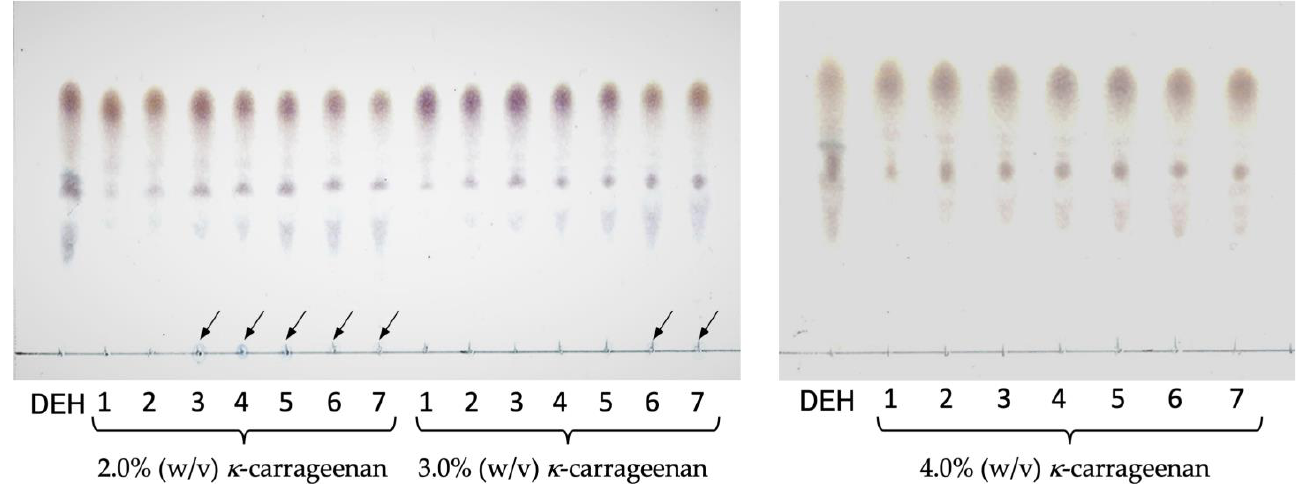
Figure 5. TLC analysis of products in batch reactions with immobilized enzymes. iAlyFRA and iAlyFRB were prepared with 2.0%, 3.0%, and 4.0% ( w / v ) κ -carrageenan. They were added to 1.0% ( w / v ) low molecular weight sodium alginate, and their reaction solutions were replaced daily. The numbers indicate the number of batch reactions. Arrows indicate undegraded substrates.